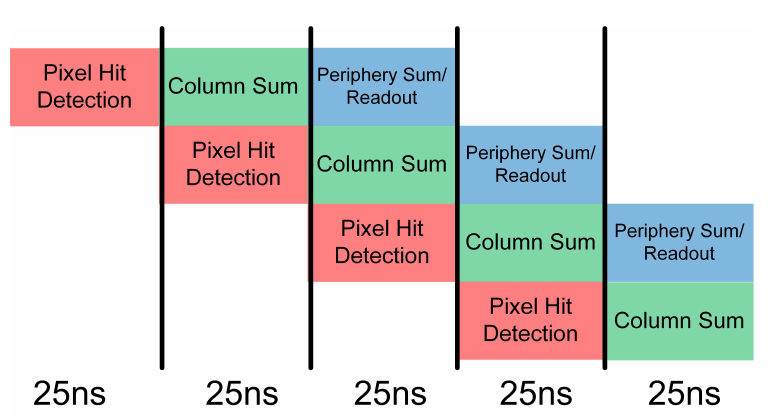
Figure 2. Top-Level plan of the chip.